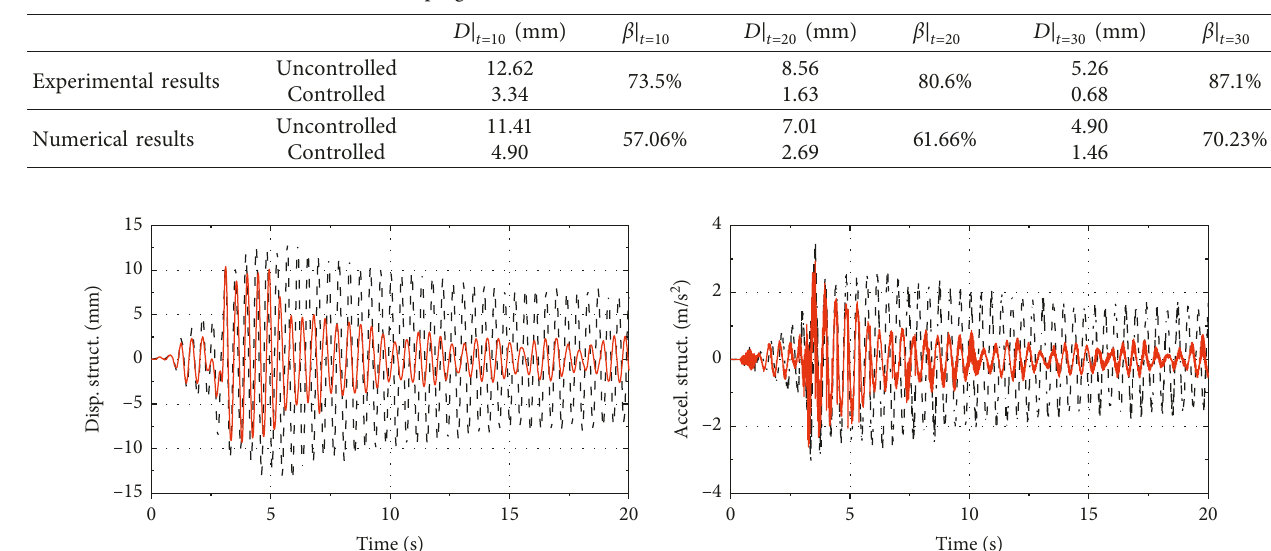
Table 5: Damping effect of the structure with PTRMD at 10s, 20s, and 30s.